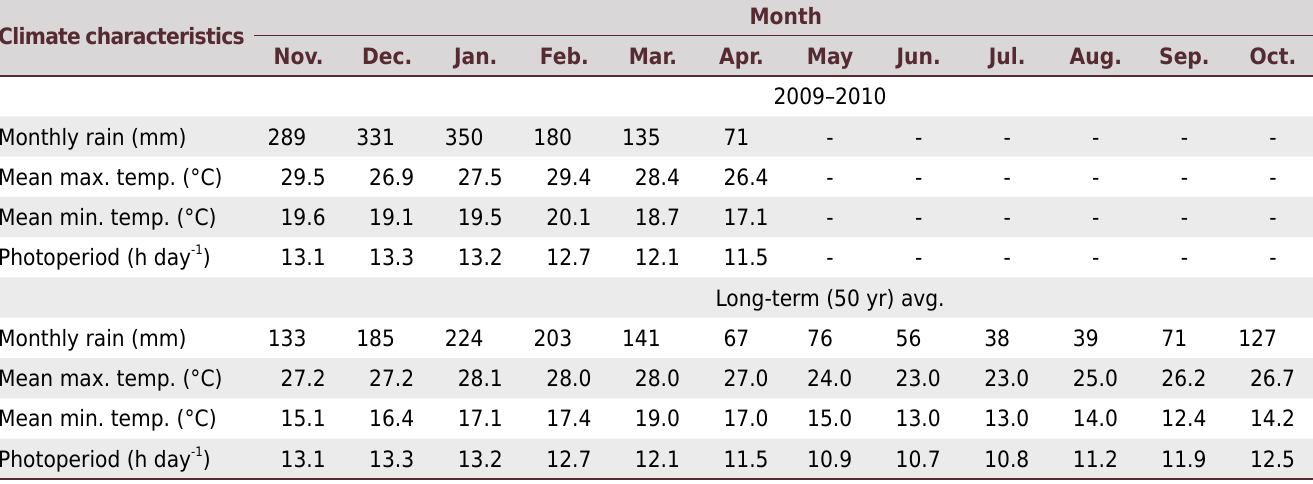
Table 1. Rainfall, maximum and minimum temperatures, and photoperiod at Botucatu, state of São Paulo, Brazil, during the study period (November to April) and long-term averages Climate characteristics